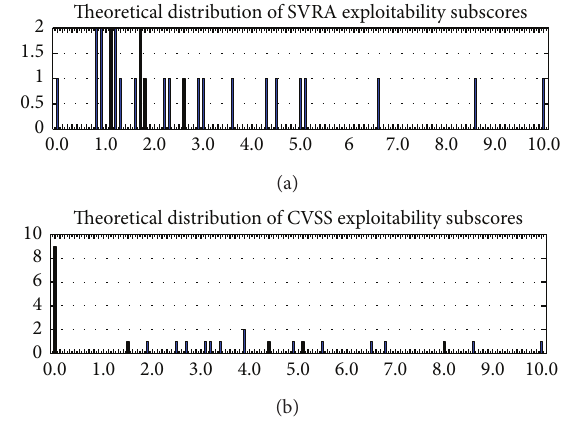
Figure 3: Theoretical distributions of exploitability subscores for SVRA (a) and CVSS v2 (b), where 𝑇 = {2002; 2003, .. .} and 𝑡 = 2012 .